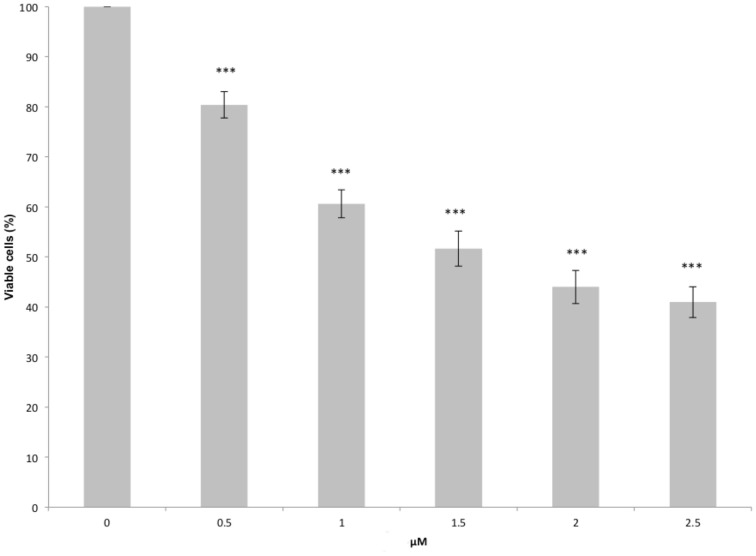
FeC-3 induced decrease of the viability of MCF10A cells. Cells were treated with different concentrations of sensitizer for 48 h. Viability was determined by the crystal violet assay. Graphical results represent the mean of 5 independent experiments ± the standard error mean (SEM). Differences between untreated and treated cells were statistically significant for ***p < 0.001.